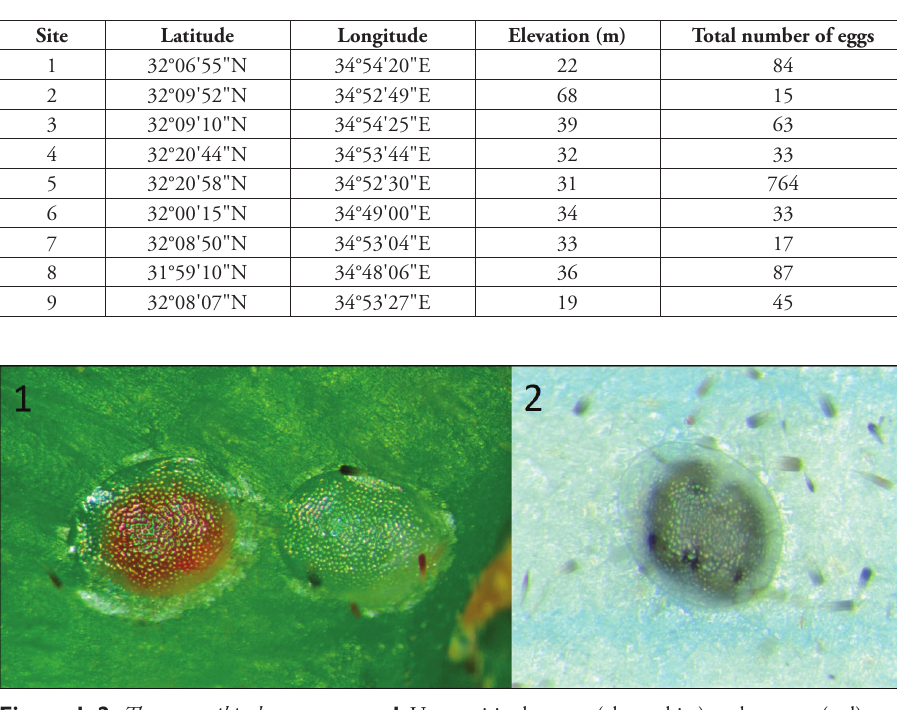
Table 1. The Universal Transverse Mercator (UTM) coordinates of nine castor bean collection sites, and the number of FCM eggs that were found in each location.